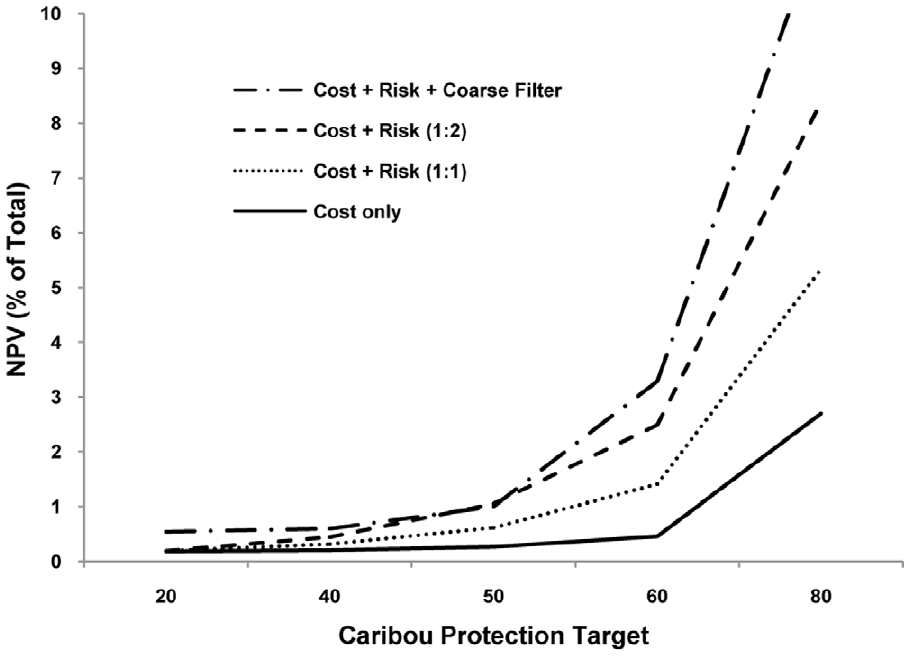
Figure 6. Opportunity cost of the reserve system relative to the caribou protection target. Cost is expressed as a percentage of the NPV of the entire study area. Three variations of Scenario 2 are shown, illustrating different relative weightings of cost to risk. Results are also shown for Scenario 3 (coarse-filter).